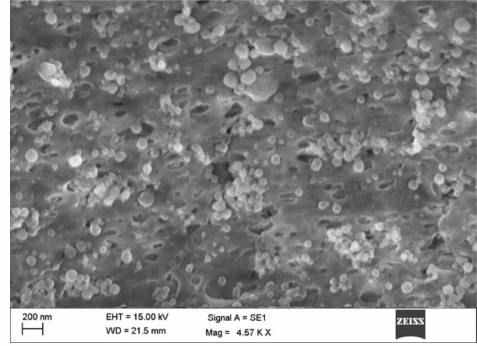
Figure 7. Scanning electron microscope (SEM) image of NTS–loaded in situ gel.